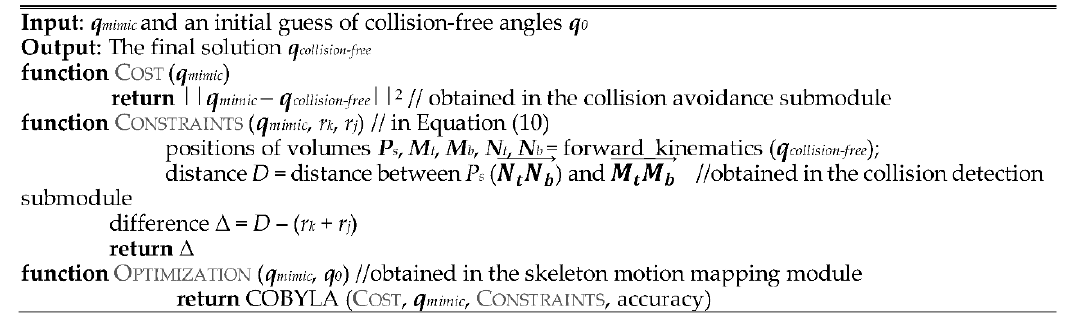
Figure 7. Pseudo-code for searching collision-free angles.